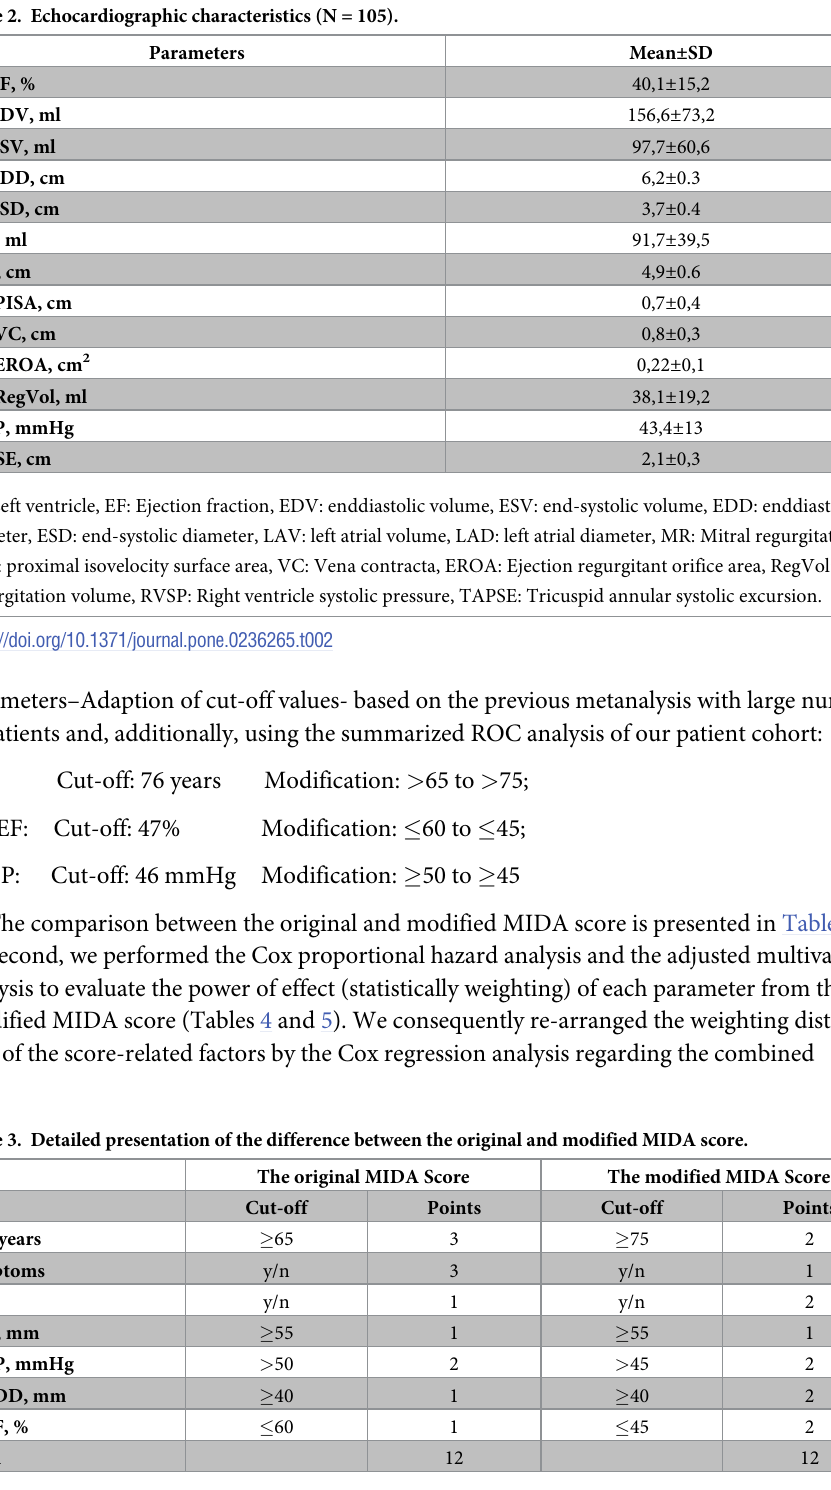
Total AF: Atrial fibrillation, LV: Left ventricle, EF: Ejection fraction, EDD: enddiastolic diameter, LAD: left atrial diameter, RVSP: Right ventricle systolic